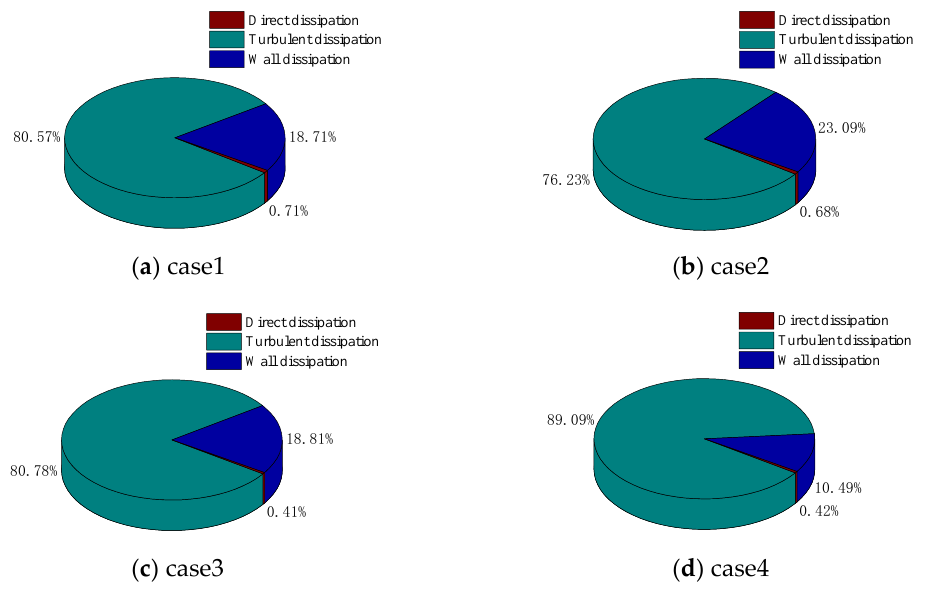
Figure 10. Percentage of entropy production by type.